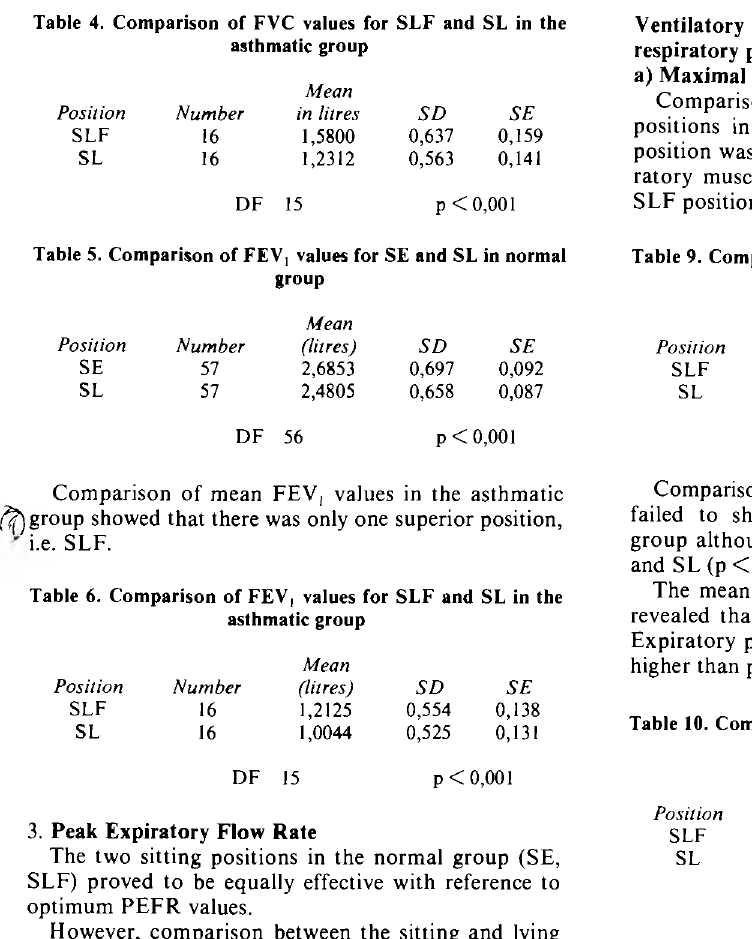
Table 7. Comparison of PEFR values in SE and SL positions in the normal group